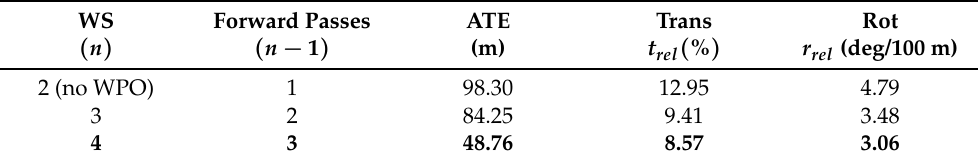
Table 4. Effects of different window sizes ( ws ) on MPO-Net (the least error results are high-lighted in bold